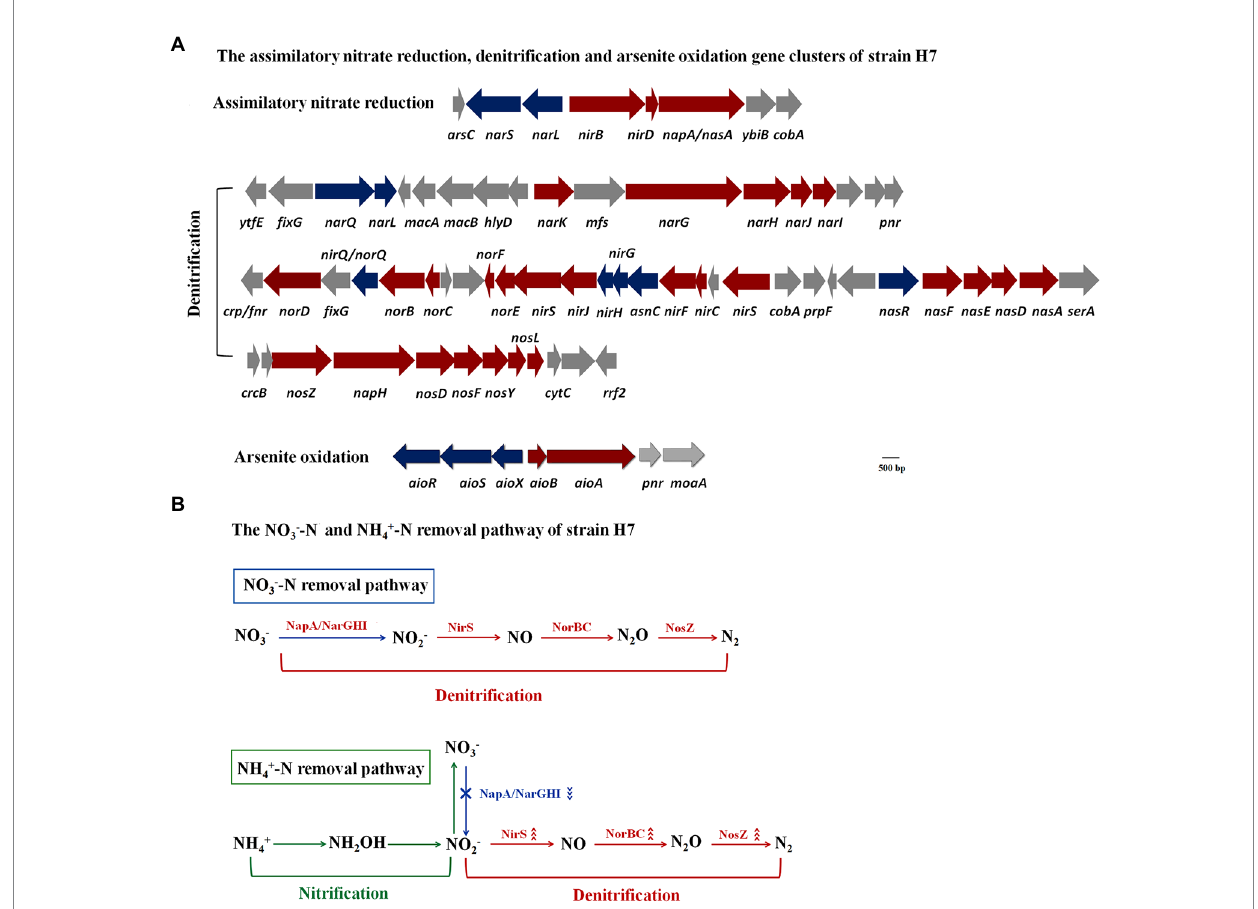
FIGURE 6 The assimilatory nitrate reduction, denitrification, and arsenite oxidation gene clusters (A) and the NO 3 − -N and NH 4+ -N removal pathways of strain H7 (B)